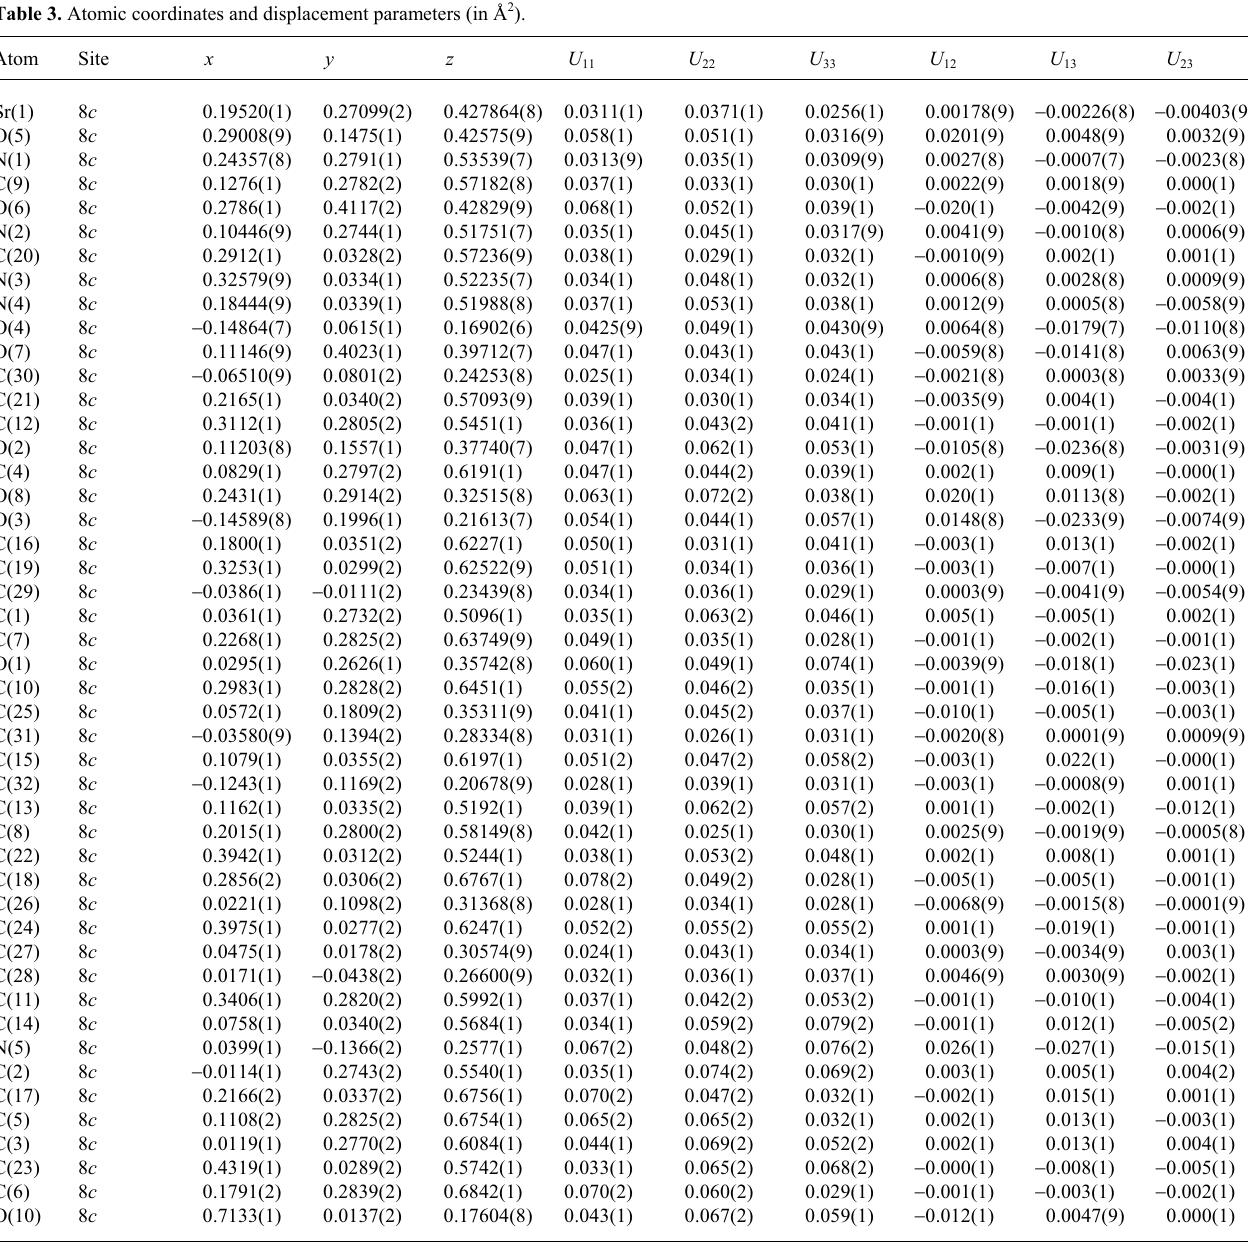
Table 3. Atomic coordinates and displacement parameters (in Å 2 ).